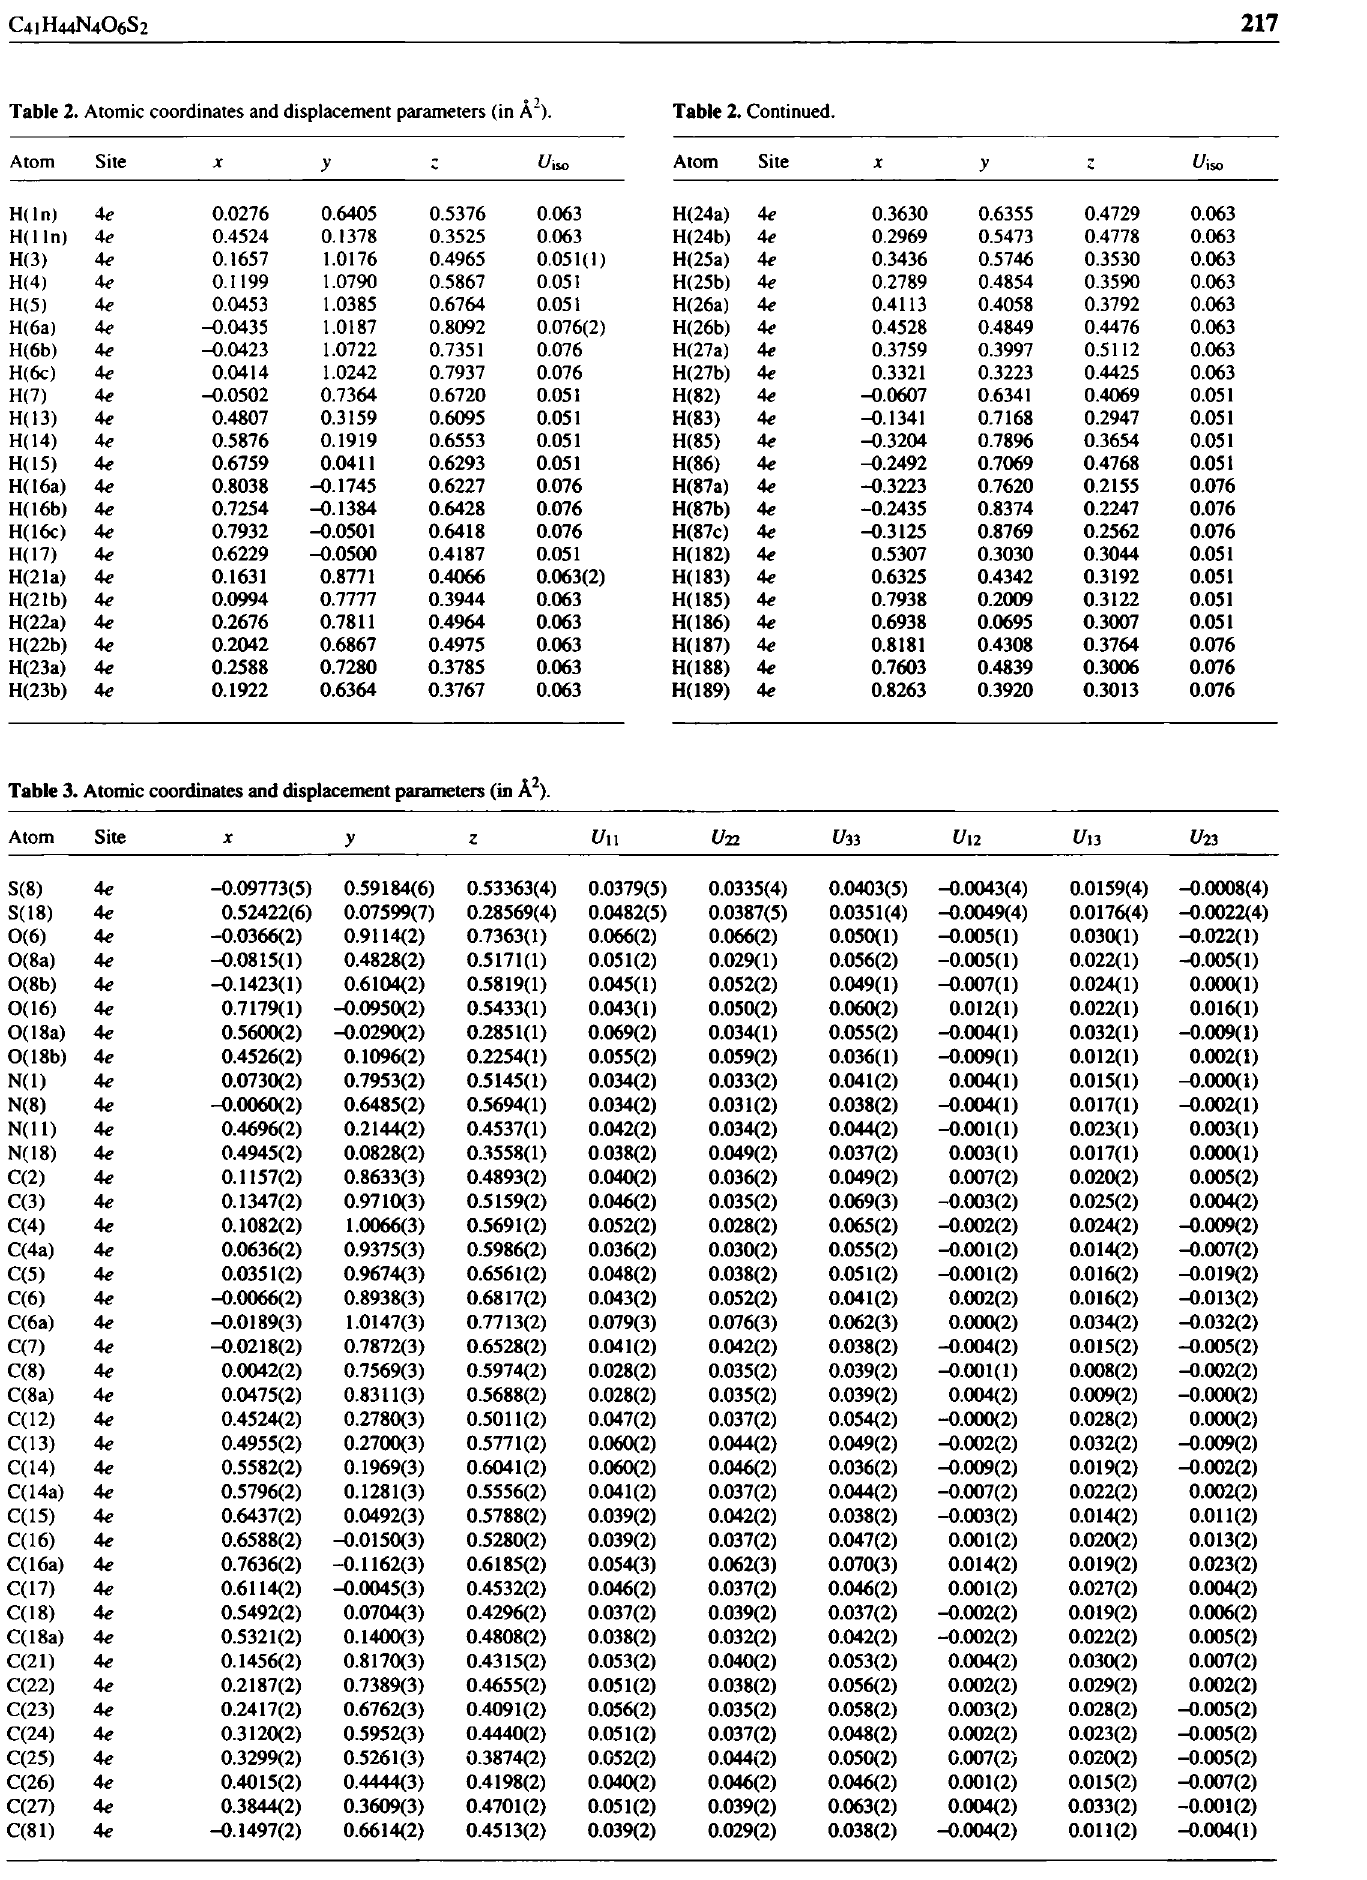
Table 2. Atomic coordinates and displacement parameters (in Ä").